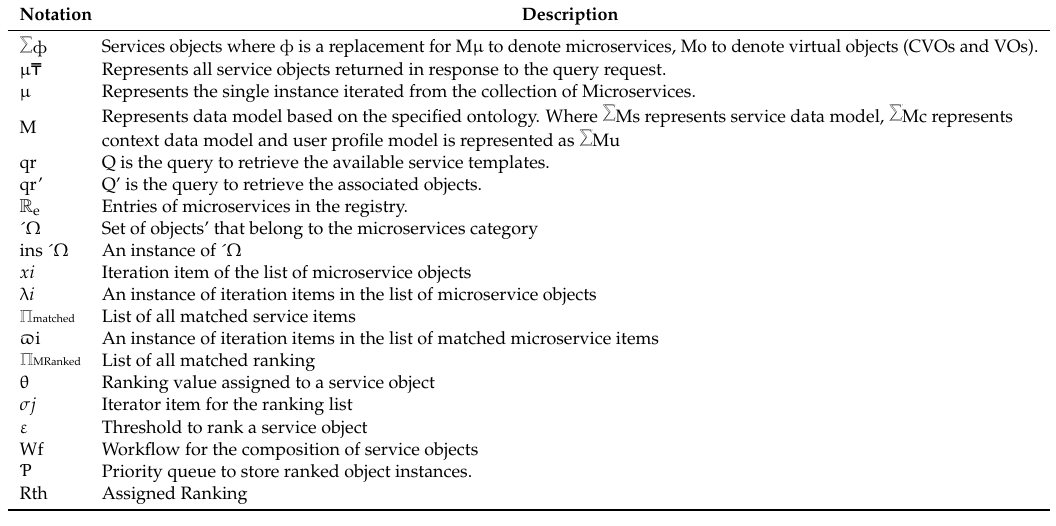
Table 2. Notations used in the algorithm.